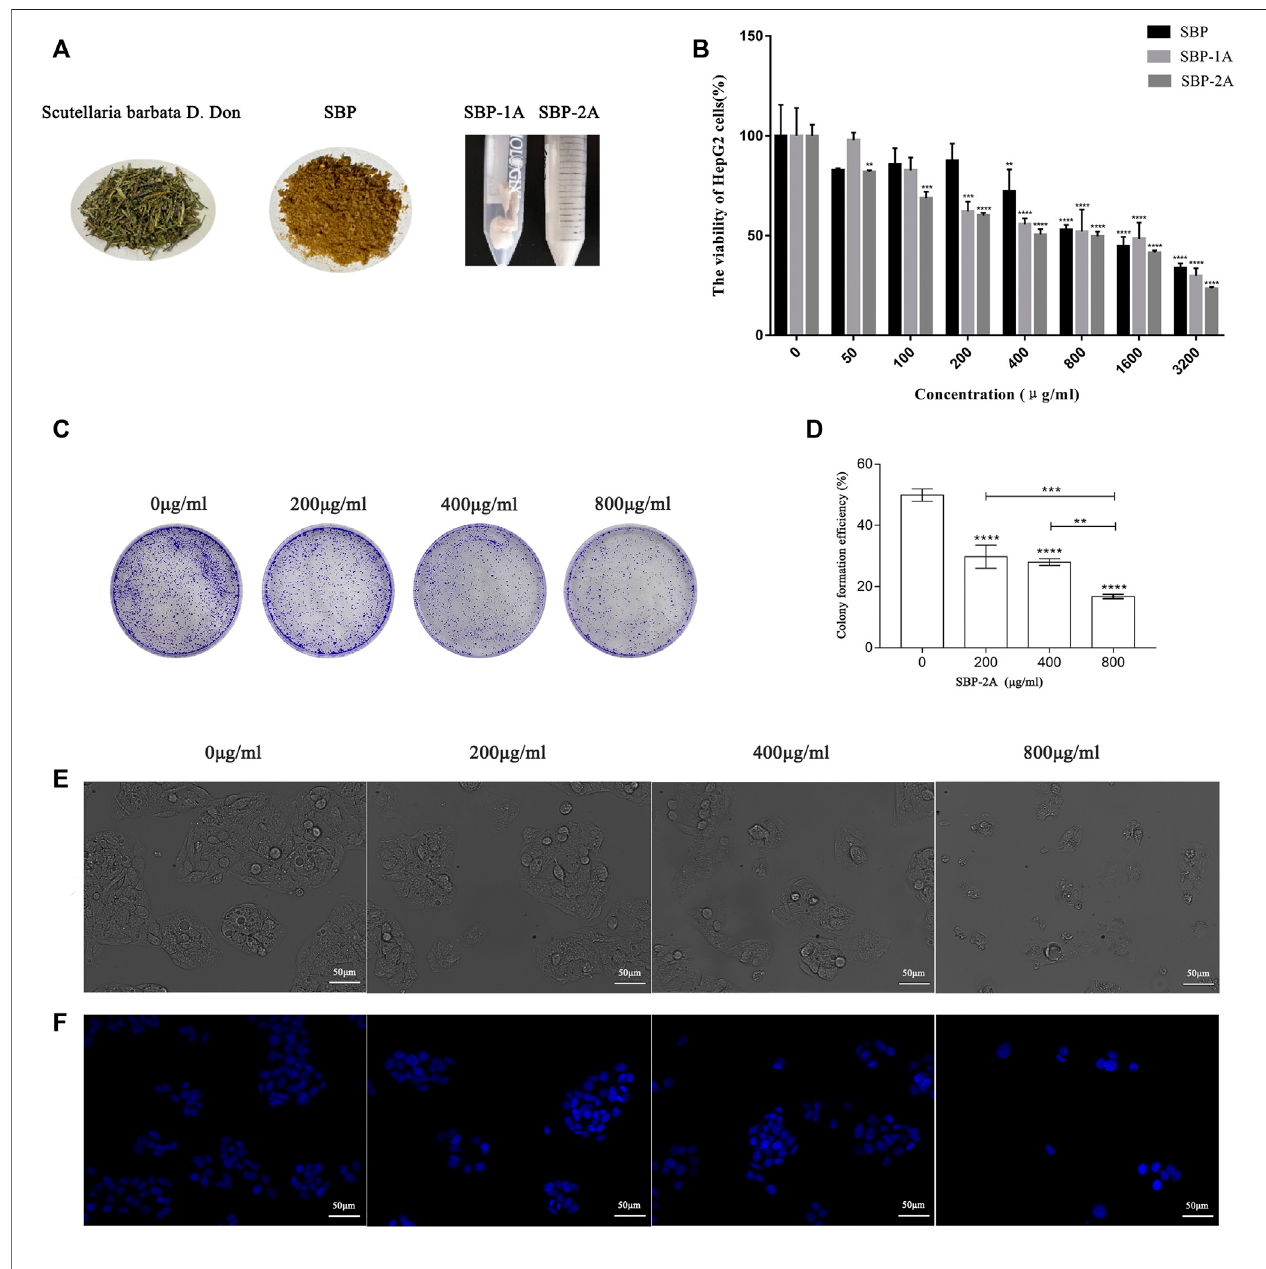
FIGURE 6 | (A) Scutellaria barbata D. Don, SBP, SBP-1A, and SBP-2A. The viability of HepG2 cells treated with SBP, SBP-1A and SBP-2A (0 – 3,200 μ g/ml) for 48 h was measured by MTT assay (B) . Colony formation assays (C,D) , in contrast to the non-SBP-2A-treated group, ** p < 0.01, *** p < 0.001, **** p < 0.0001. The morphological characteristics (E) and Hoechst 33258 staining (F) of HepG2 cells treated with different concentrations of SBP-2A for 48 h.